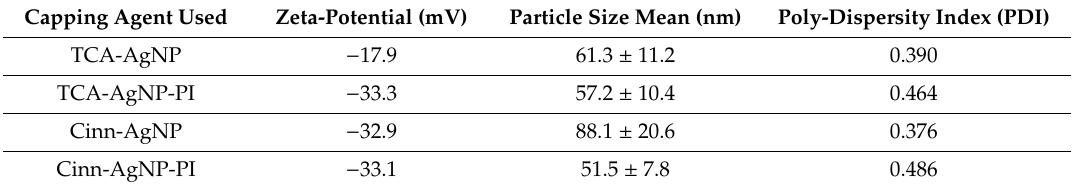
Table 1. Zeta potential measurements and DLS results for each sample of AgNPs.